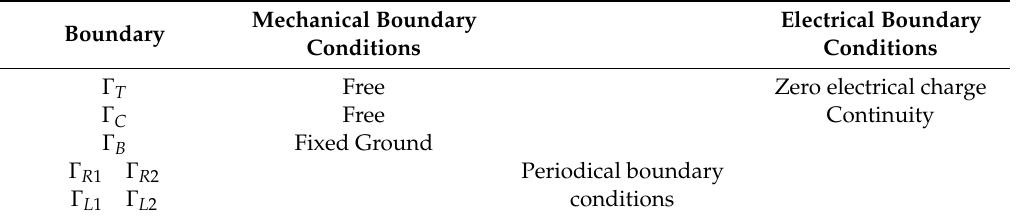
Table 4. Boundary